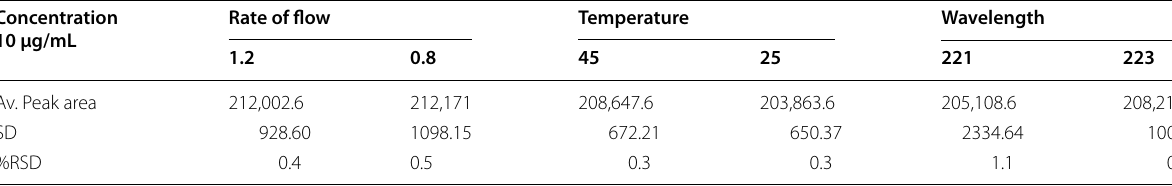
Table 5 Robustness results at different temperature, flow rate and wavelength for empagliflozin Concentration 10 µg/mL